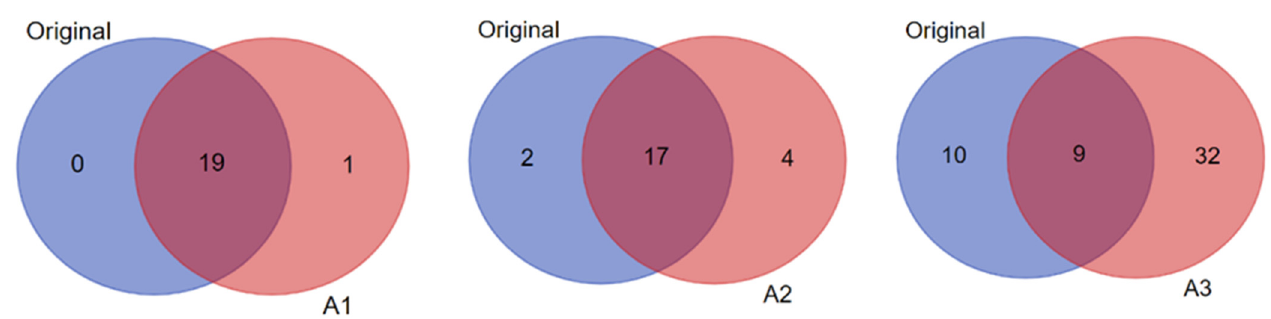
Figure 8. Pairwise comparisons (shown as Venn diagrams) between the original and the amplified datasets A1, A2, and A3 of the T1D high-risk subject group showing the numbers of biomarker predictions made by IPA in the context of "diabetes mellitus" in common between each pair (i.e., original versus A1; original versus A2; and original versus A3), and the numbers of unique predictions made in each dataset (i.e., original versus amplified).